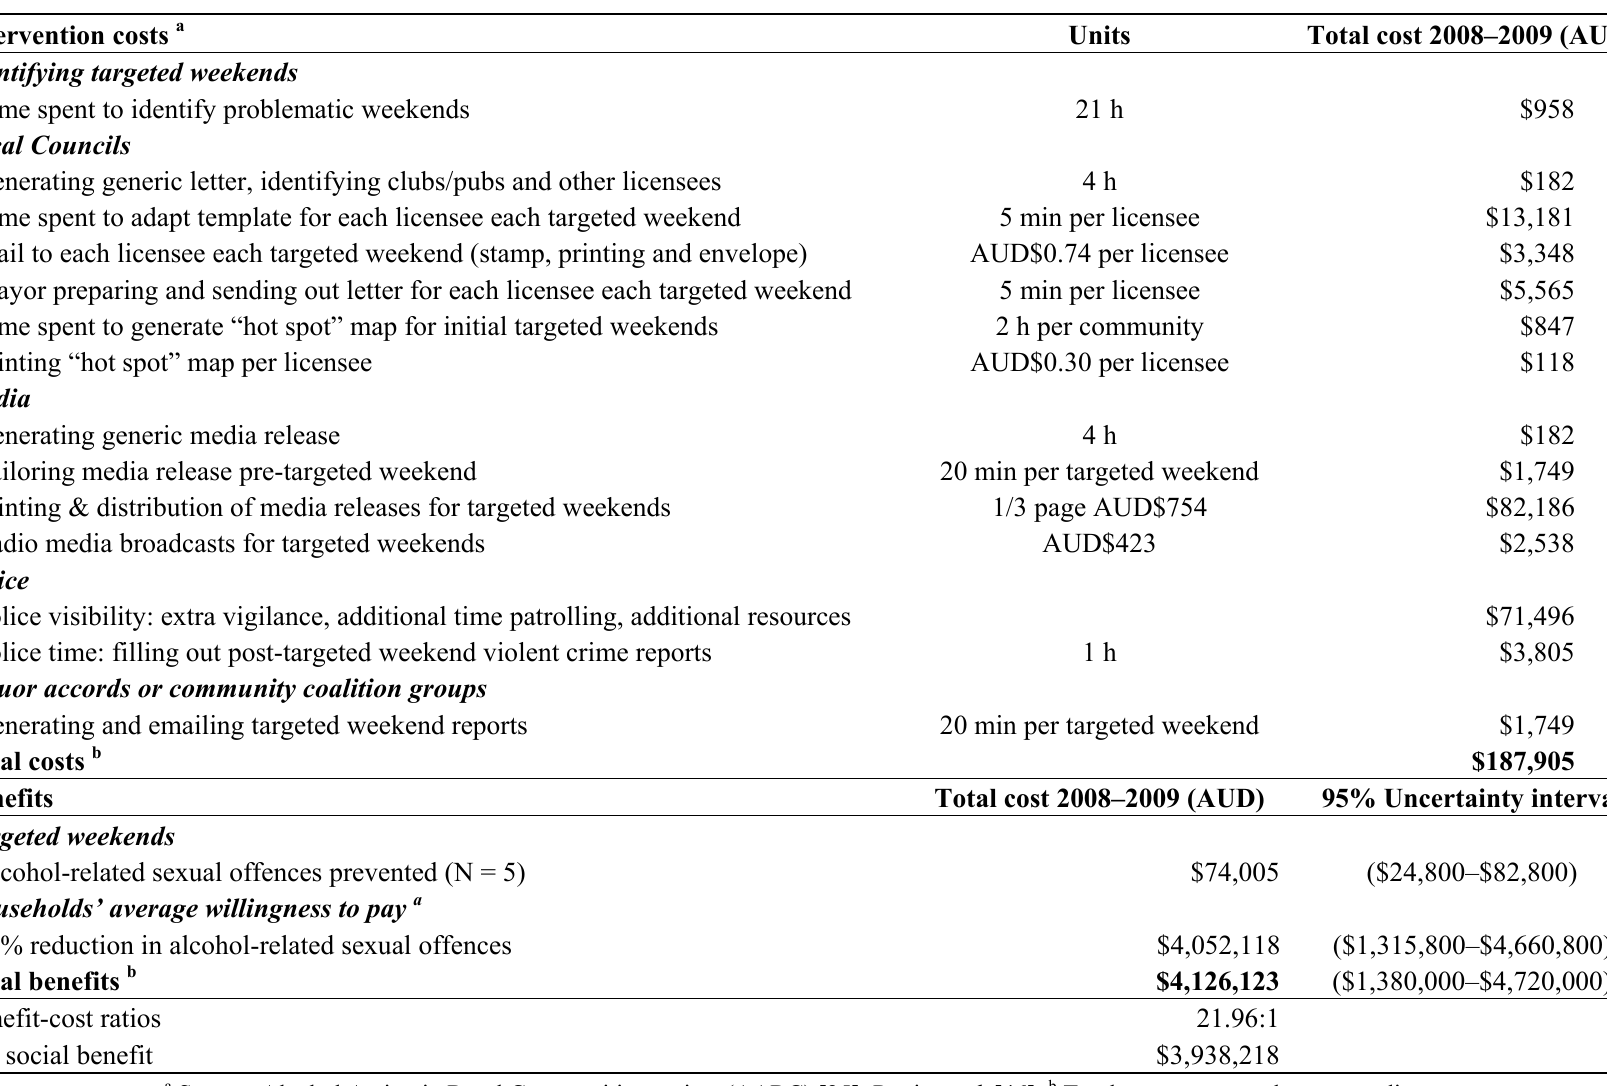
Table 3. Economic benefits and costs of targeting violent crimes associated with alcohol on problematic